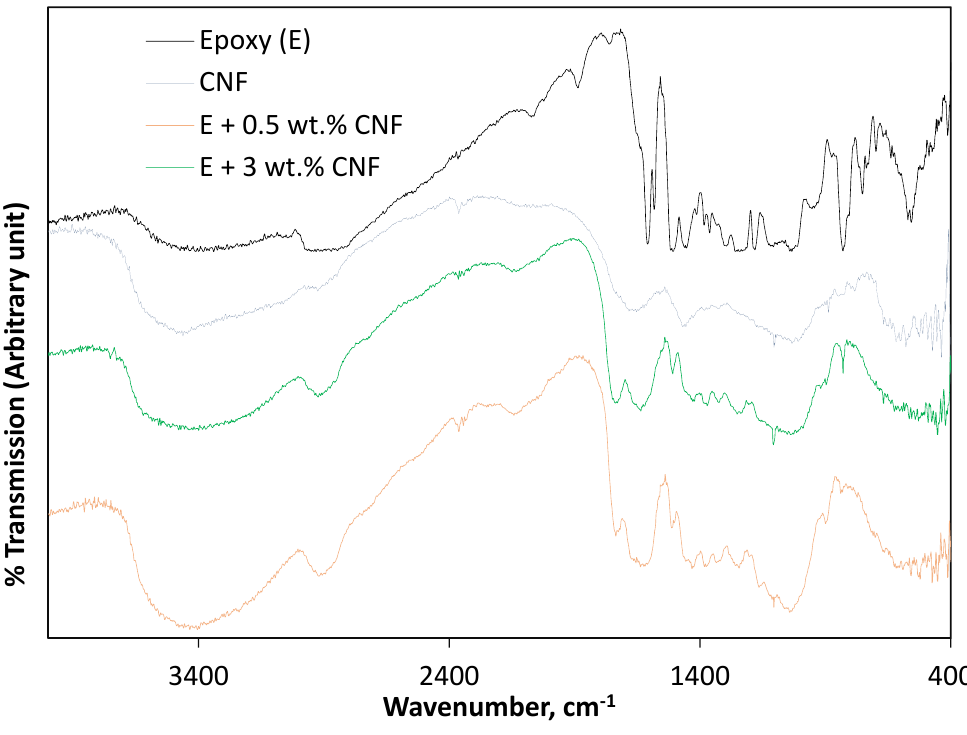
− Figure 4. FTIR spectrum of CNF, epoxy and epoxy filled with 0.5 wt.% CNF and 3 wt.% CNF-filled nanocomposites.